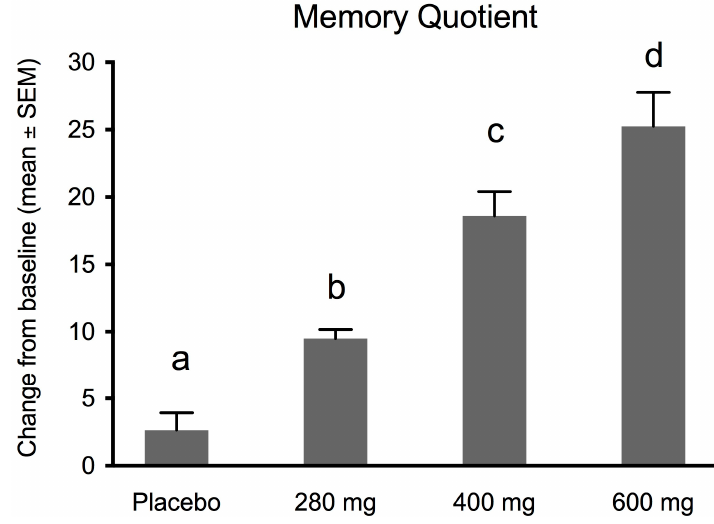
Figure 1. Changes in memory quotient (MQ) before and after silk fibroin protein enzymatic hydrolysate (FPEH) intake at daily doses of 0, 280, 400 and 600 mg for 3 weeks. Each value is the mean with the standard error of the mean (SEM). Groups with a different alphabetical letter are statistically significantly different on the basis of group tests following ANOVA ( F = 32.97; df total = 62; p < 0.00013). Between group p values were the following: placebo: 280 mg, p < 0.00015; placebo: 400 mg, p < 0.0001; placebo: 600 mg, p < 0.0001; 280 mg: 400 mg, p < 0.0001; 280 mg: 600 mg, p < 0.0001; 480 mg: 600 mg, p < 0.0378.